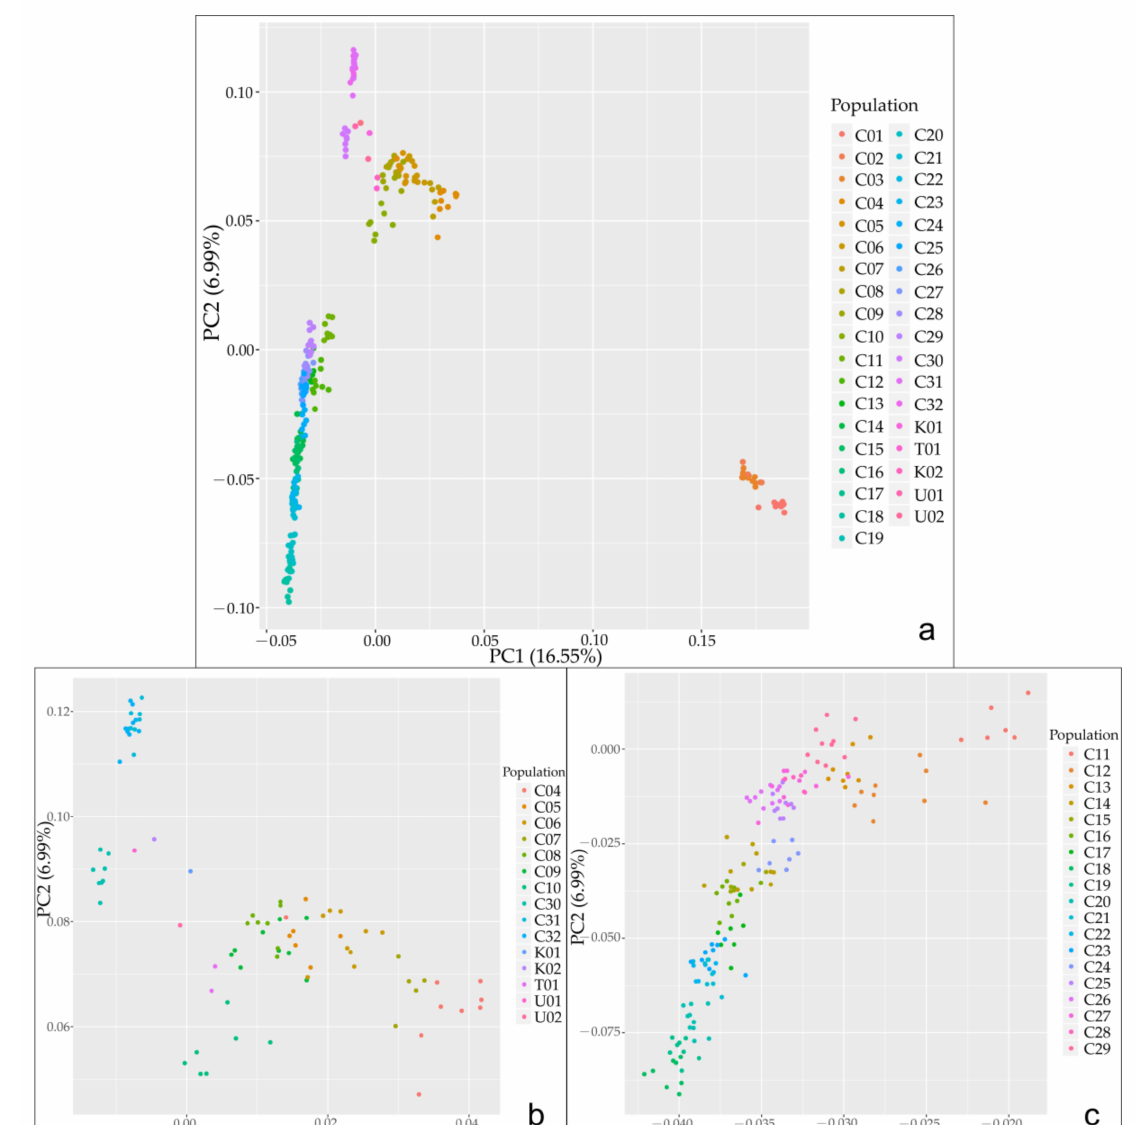
tions (Figure S3, Table S3), with F ST values on a scale from 0.076 to 0.707 (Table S3). The maximum genetic differentiation was detected between C02 (Sarang population) and K01 (Bishkek population) ( F ST = 0.707), while the minimum genetic differentiation existed between C27 (Shihezi population) and C29 (Wusu population) ( F ST = 0.076) (Table S3). Nei ’s genetic distance was roughly synchronous with pairwise F ST between populations (Figure S3). Furthermore, the result of isolation by distance (IBD) analysis displayed a con- siderable correlated pattern between genetic divergence and geographical distance among these 37 populations, given that the two-tailed test of the Pearson correlation coefficient was of significance ( r = 0.499, p < 0.001) (Figure 6).